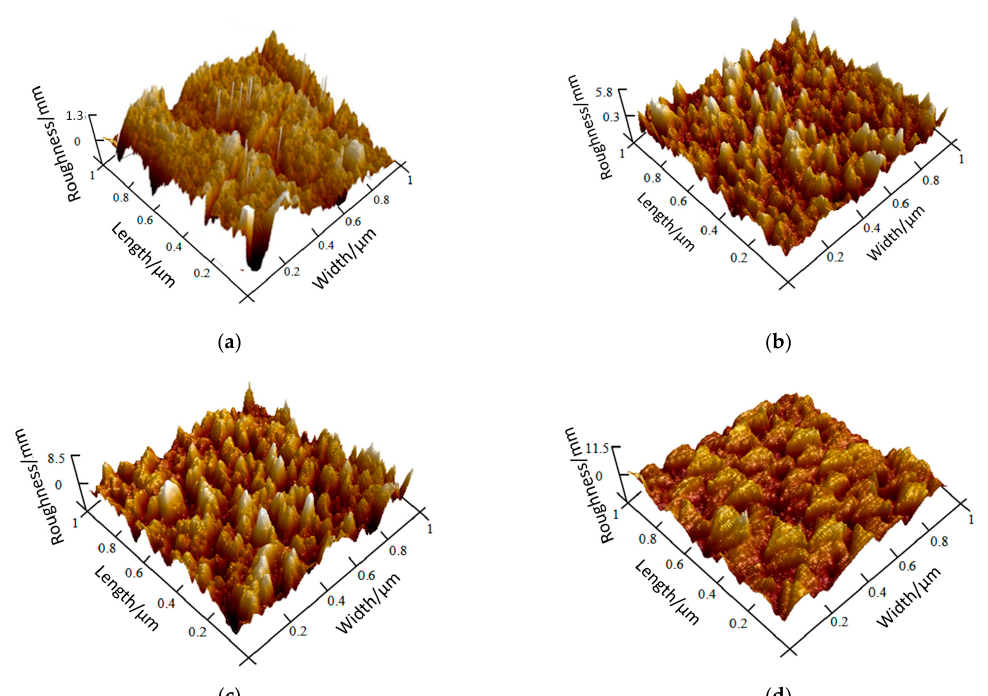
Figure 9. AFM diagram of functional thin films: ( a ) Al 2 O 3 functional thin films, ( b ) NiCr functional thin films, ( c ) NiSi functional thin films, ( d ) SiO 2 functional thin films.